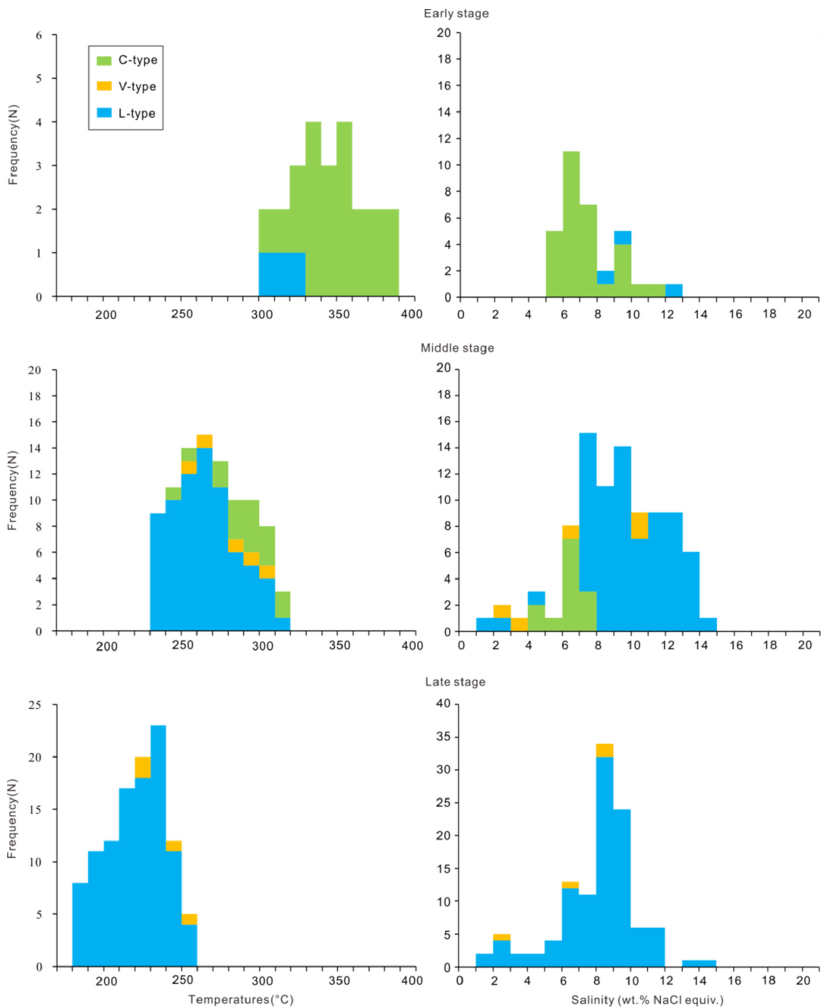
Figure 6. Histograms of total homogenization temperatures and salinities of different fluid inclusions from the three stages in the Baiyinhan tungsten deposit. Table 2. Hydrogen and oxygen isotopic compositions of quartz from the Baiyinhan tungsten deposit. Sample No.